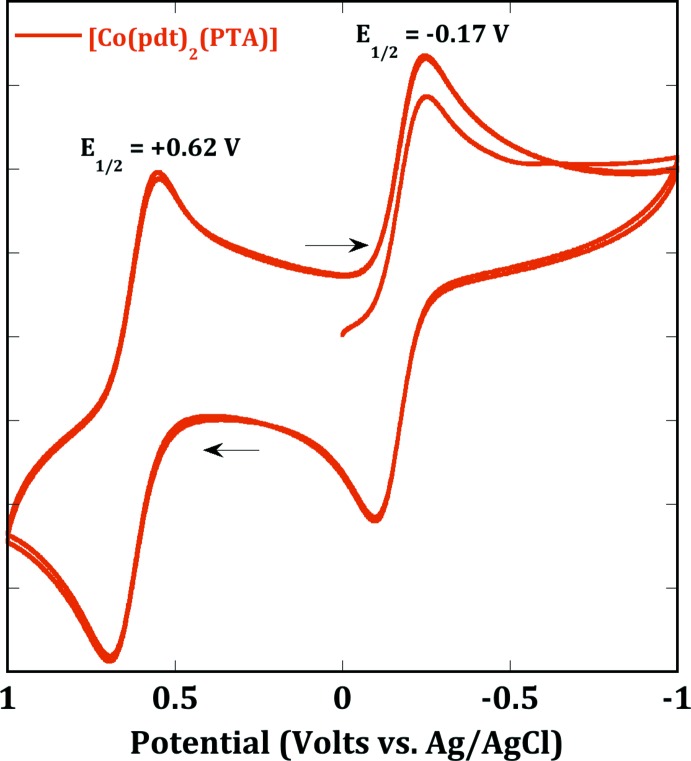
Cyclic voltammetry of [Co(pdt)2(PTA)] in CH2Cl2 recorded using a platinum working electrode and [nBu4N][PF6] as electrolyte with a scan rate of 100 mV s−1 at 25°C.